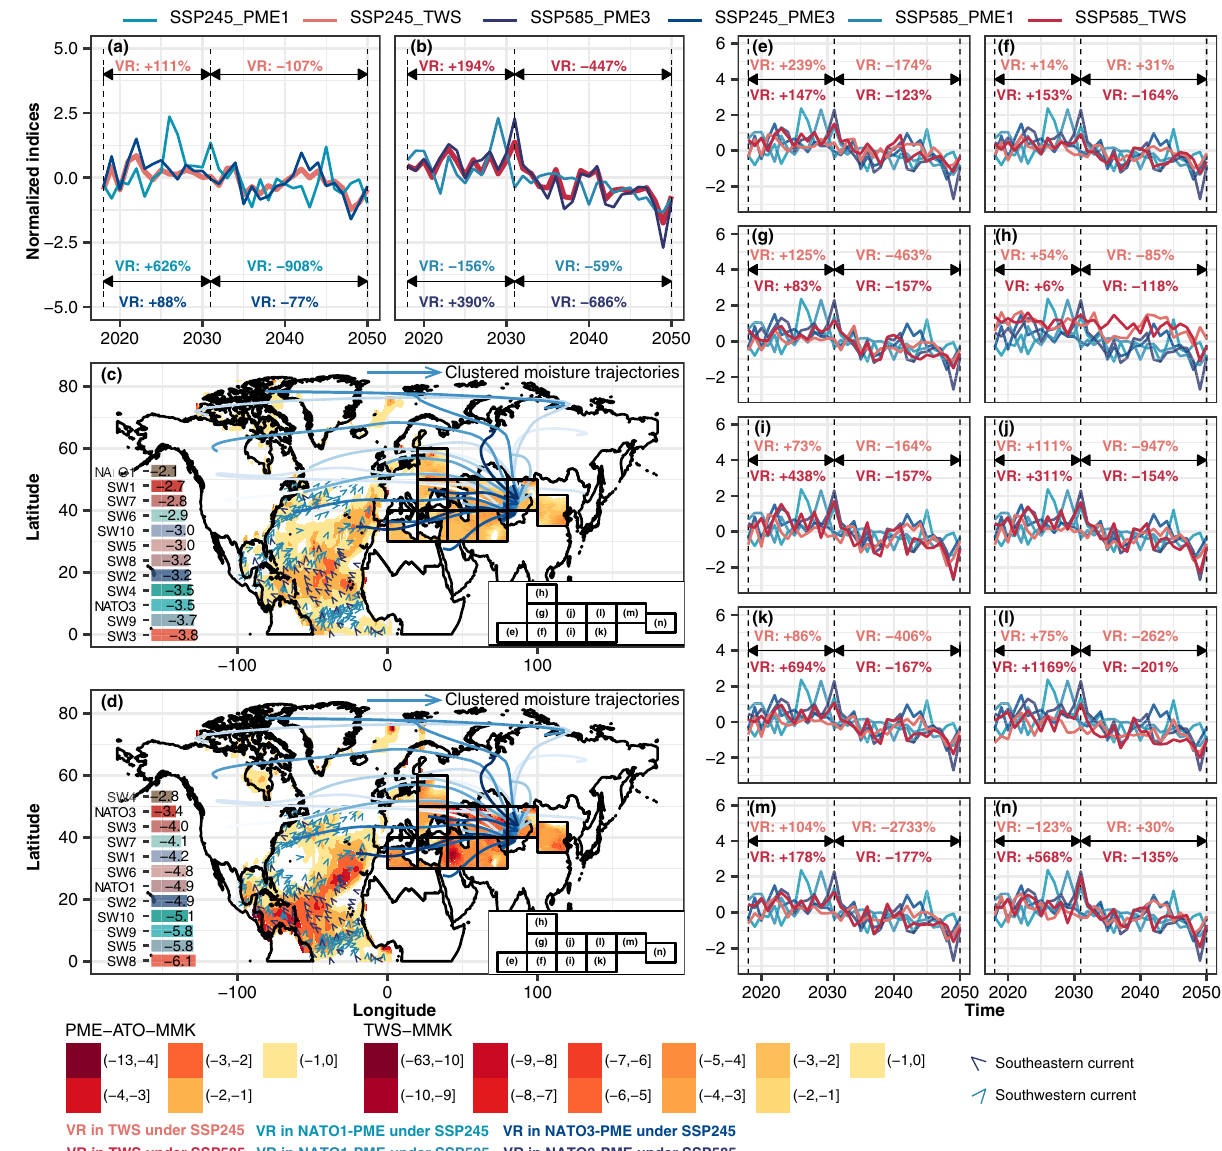
Fig. 4 Projected spatiotemporal evolutions in PME over NATO and TWS in HSR1-10. Temporal variations in the annual-sum normalized trend items of the zonal sums of TWSs across the whole HSR1-10 and variations in the annual-sum normalized trend items of zonal sums of PMEs in NATO1 and NATO3 under SSP245 and SSP585 during 2018 – 2050 ( a , b ). Spatial patterns of the modi fi ed Mann-Kendall (MMKs) trends of PME over NATO and TWS in HSR1- 10 under SSP245 ( c ) and SSP585 ( d ) during 2018 – 2050 ( c , d ). Temporal variations in the annual-sum normalized trend item of the zonal sum of TWS over every HSR and annual-sum normalized trend items of the zonal sums of PMEs in NATO1 and NATO3 under SSP245 and SSP585 during 2018 – 2050, respectively ( e – n ). The VR in the plot refers to the varying rates of indices during the time interval, i.e., 2018 – 2031 and 2031 – 2050. The moisture trajectories in subplot ( c , d ) were categorized using the k -means cluster method based on the locations of water particles.